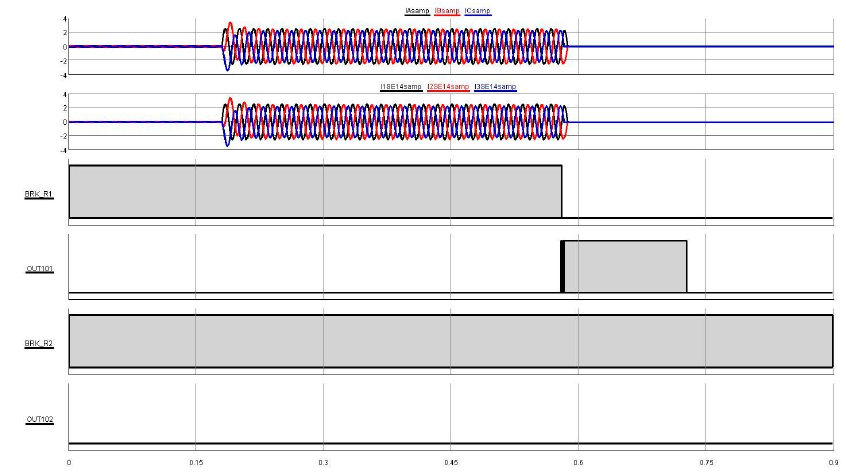
Figure 29. Waveforms when relay R1 operates to clear the fault.